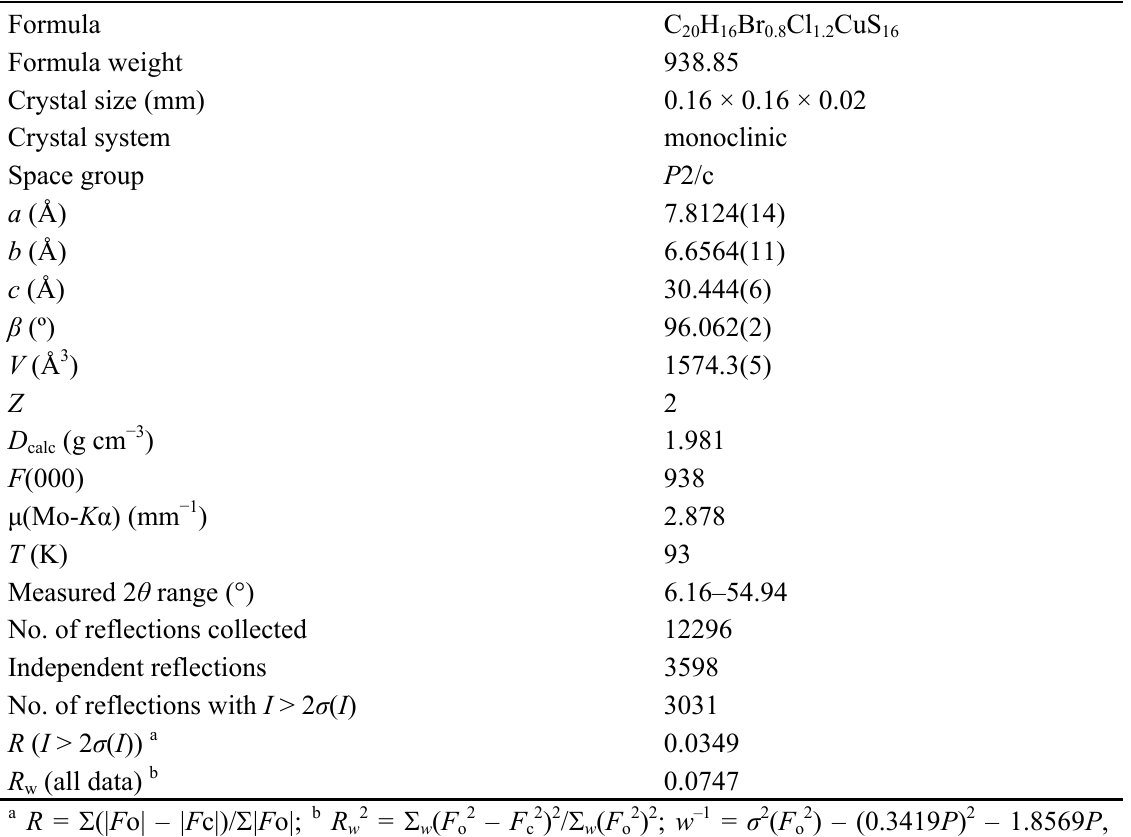
Table 1. Crystallographic data for 1 .